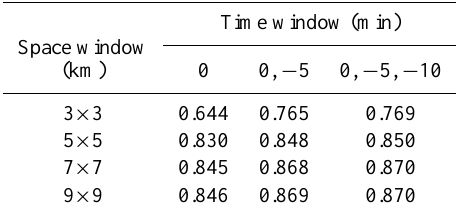
Correlation coefficient of Z e − R pairs for different WCMM scenarios.